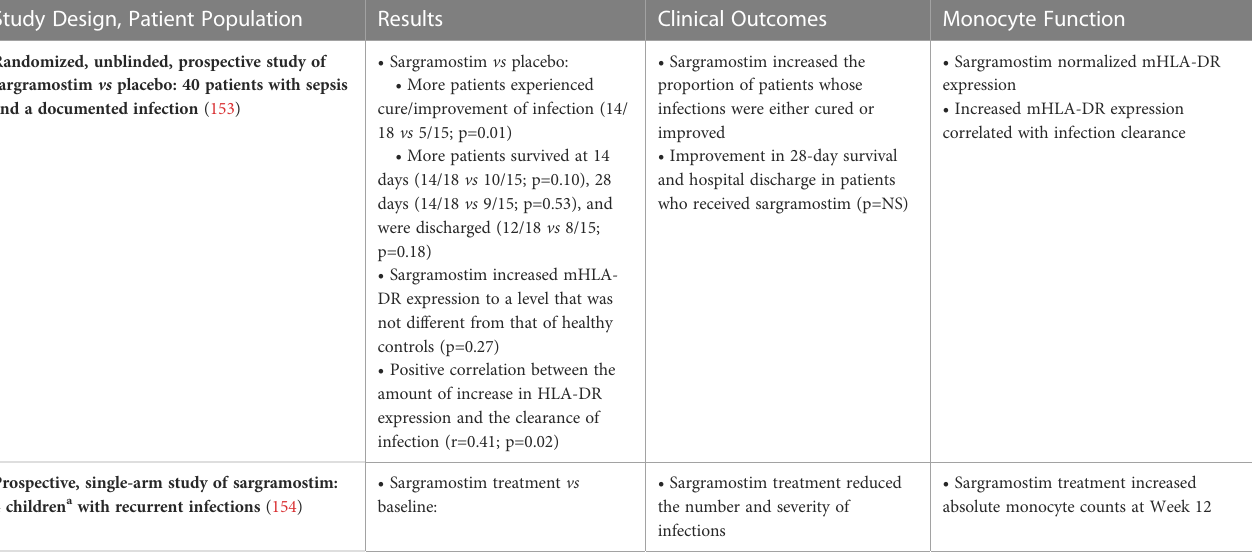
TABLE 3 Use of sargramostim in sepsis to improve clinical outcome and restore normal monocyte function. Study Design, Patient Population Results Clinical Outcomes Monocyte Function Randomized, unblinded, prospective study of sargramostim vs placebo: 40 patients with sepsis and a documented infection